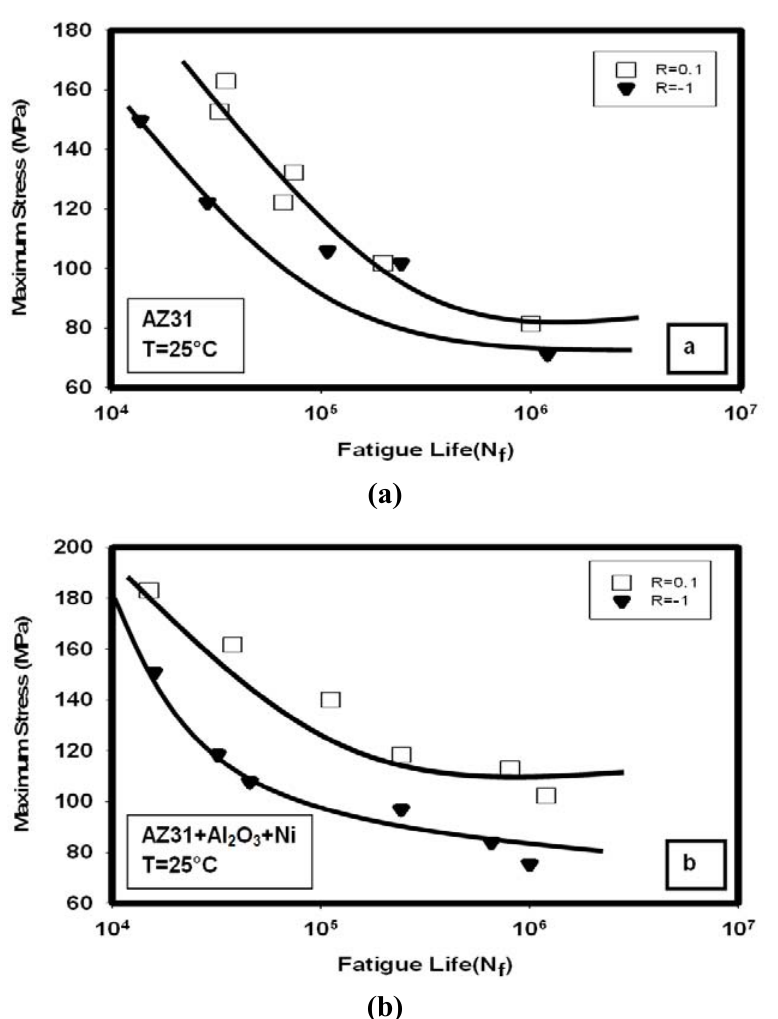
Figure 6. Comparison of the influence of load ratio (0.1 versus − 1.0) on variation of maximum stress with fatigue life (N ) for test specimens cyclically deformed at room f temperature (T = 25 °C) for: ( a ) Magnesium alloy AZ31; ( b ) Magnesium composite (AZ31/Al O 2 3